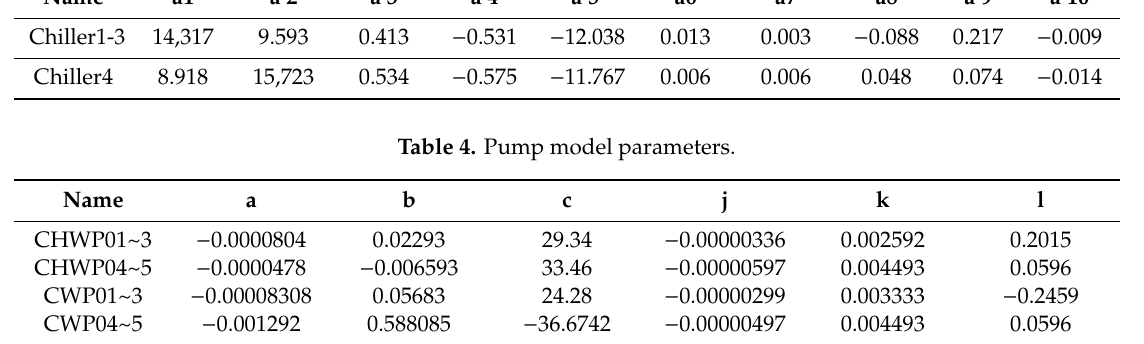
Table 4. Pump model parameters.